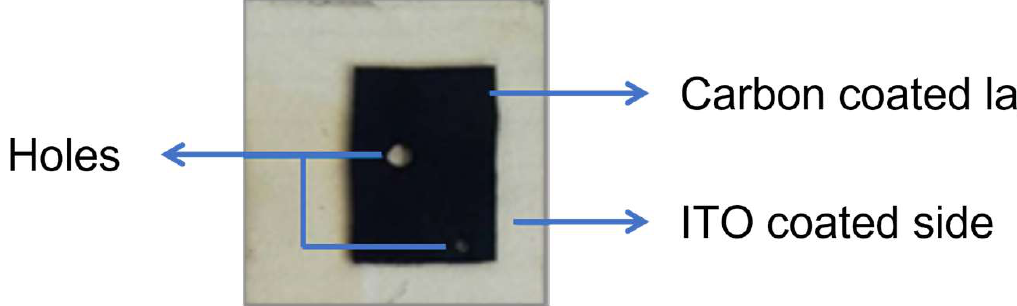
Figure 6. Carbon-coated counter electrode.